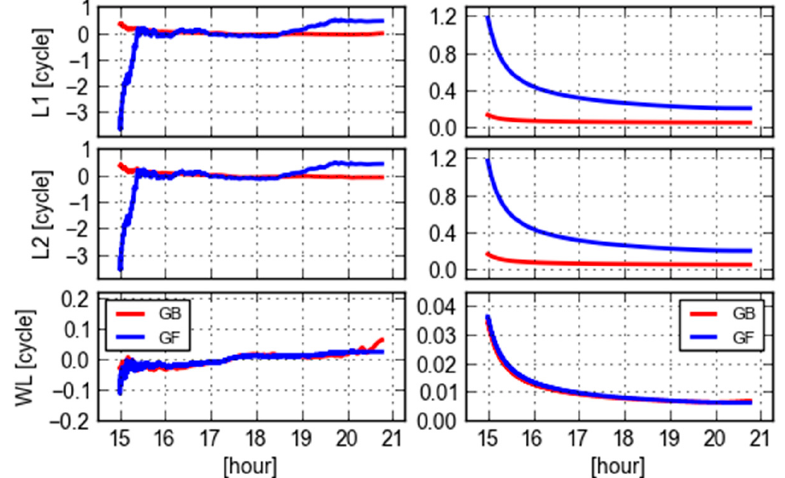
Figure 3. GF (blue) and GB (red) L1, L2 and WL ambiguities ( left ) and their corresponding formal errors ( right ) of PRN 09 computed using a single receiver (REDU) observations and ESA final orbit clock products.